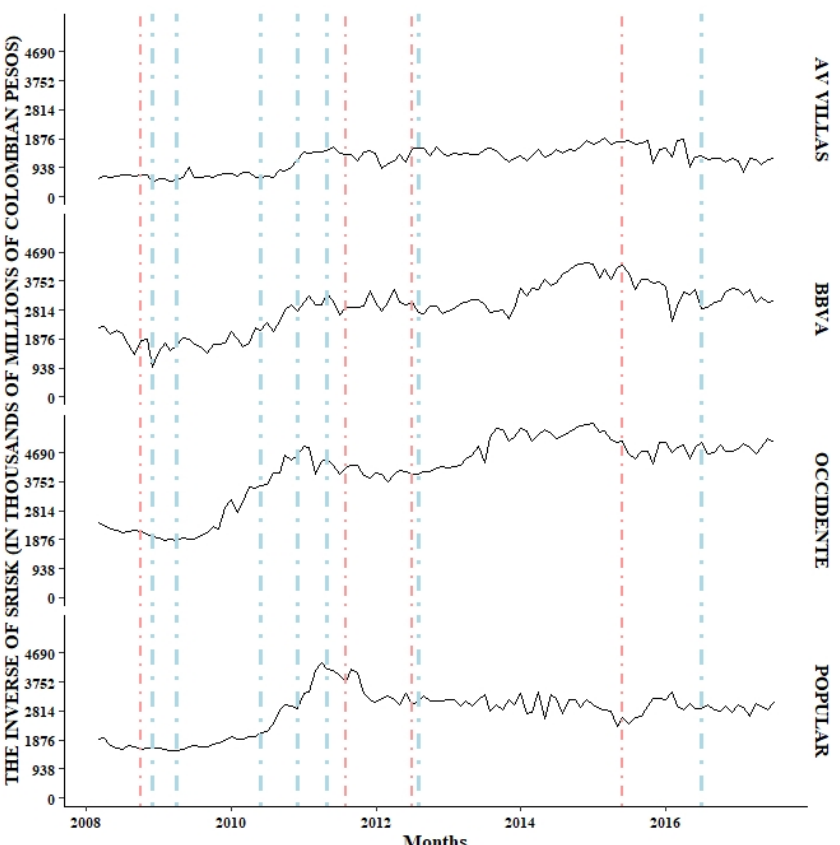
Figure 2. Monthly behavior of systemic risk measures. Source: owner.